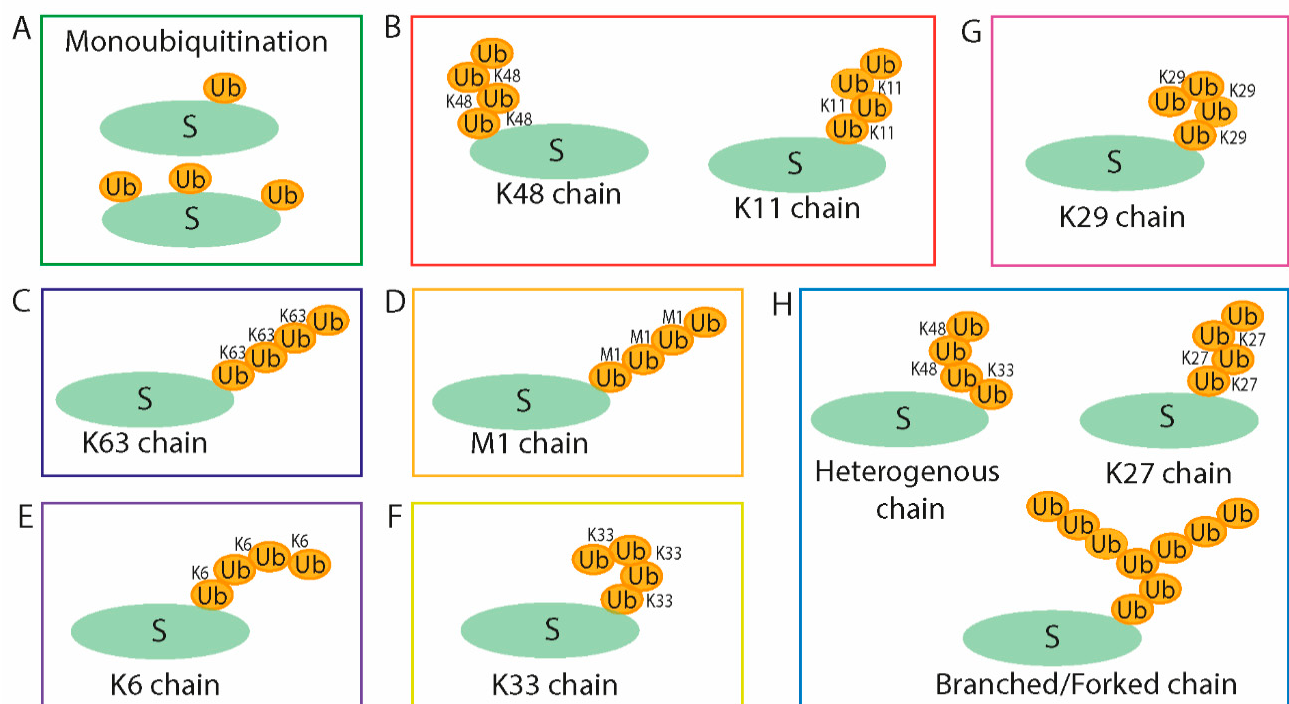
Figure 1. The ubiquitination of substrates may vary in different constructions that play a role in various cell processes: protein interaction and localization ( A ), proteasomal degradation ( B ), NF- κ B activation ( C , D ), DNA repair ( C , E , F ), lysosomal targeting ( C ), autophagy ( E ), intracellular trafficking ( F ) and epigenetic regulation ( G ), and many others still unknown functions ( H ). S—substrate, Ub—ubiquitin. Adapted from [5].